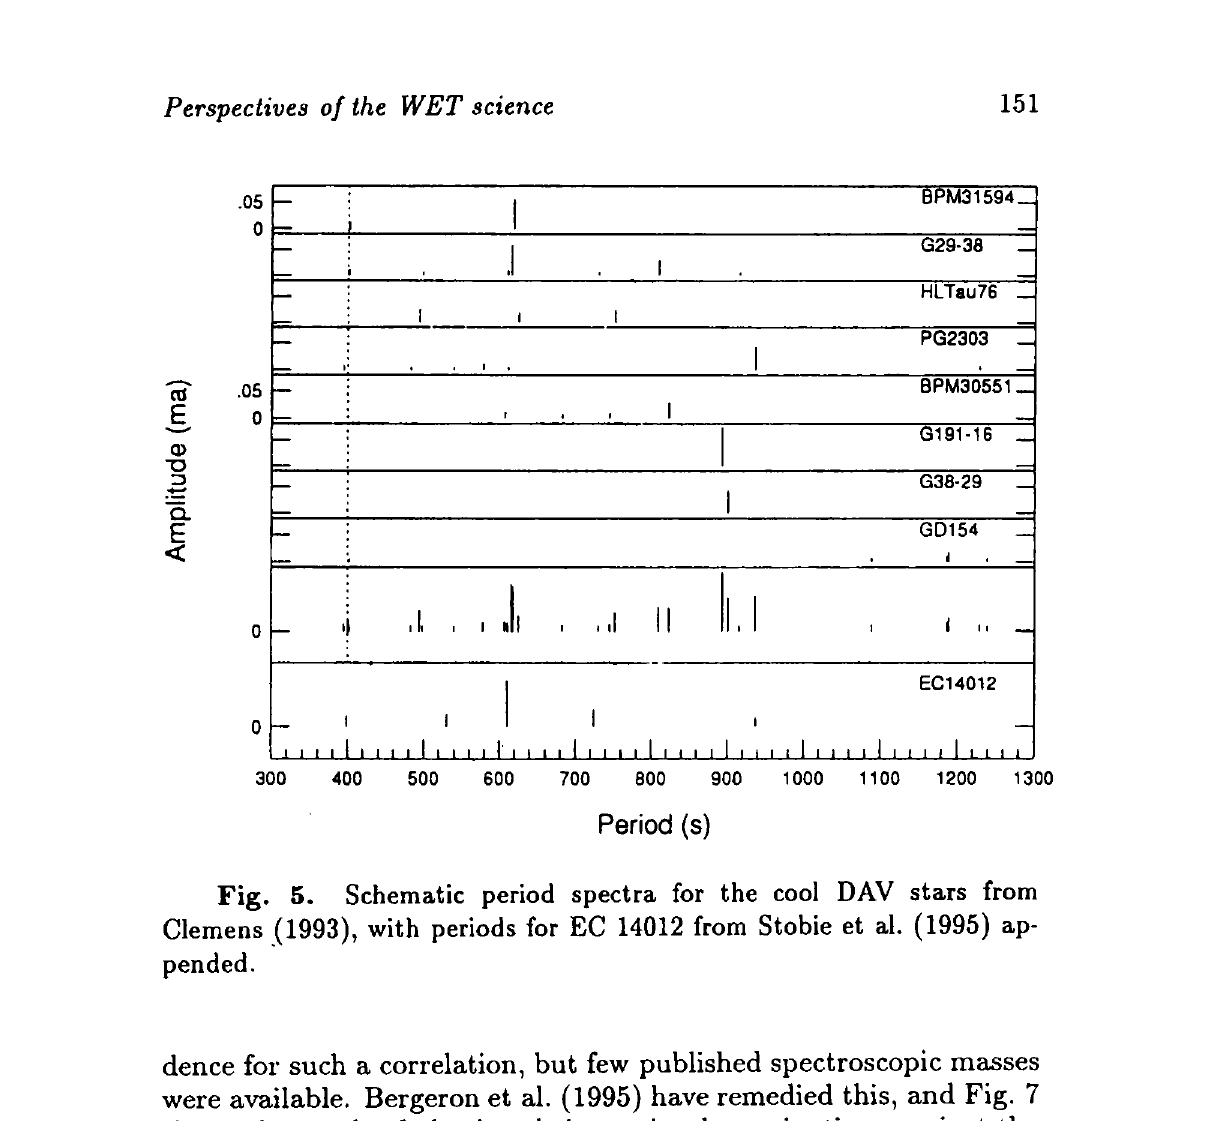
Fig. 5. Schematic period spectra for the cool DAV stars